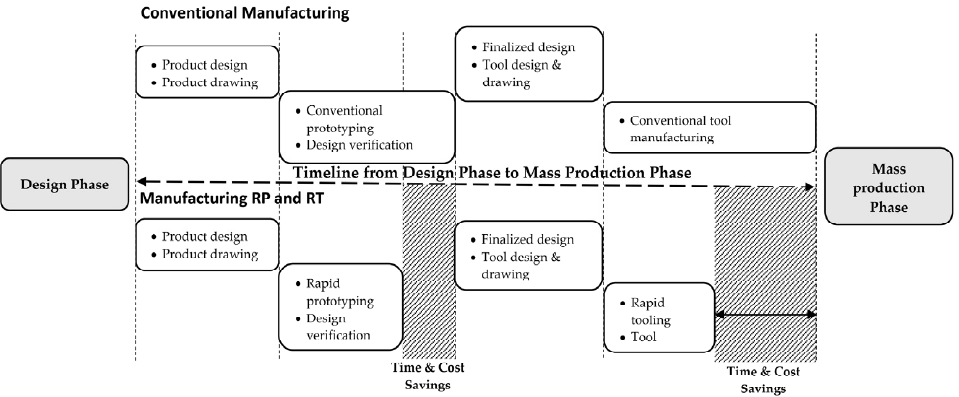
Figure 1. Summary of RT integration in manufacturing.